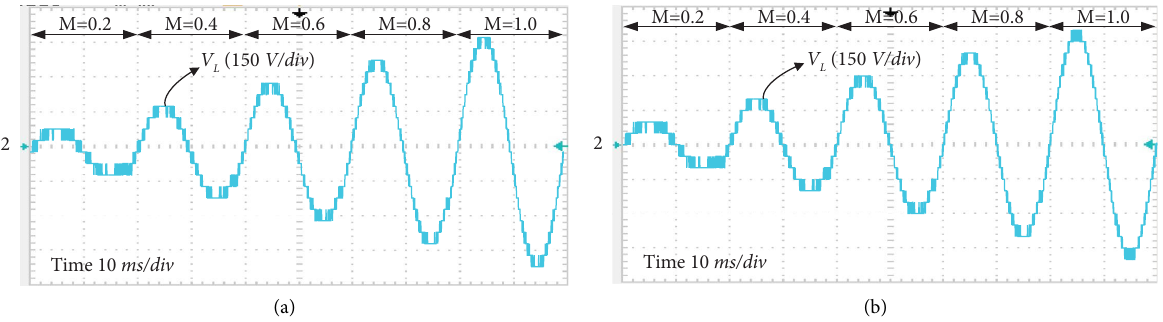
Figure 21: Experimental 11L CHB inverter line voltage for dynamic values of M . (a) SVPWM-I. (b) SVPWM-II.